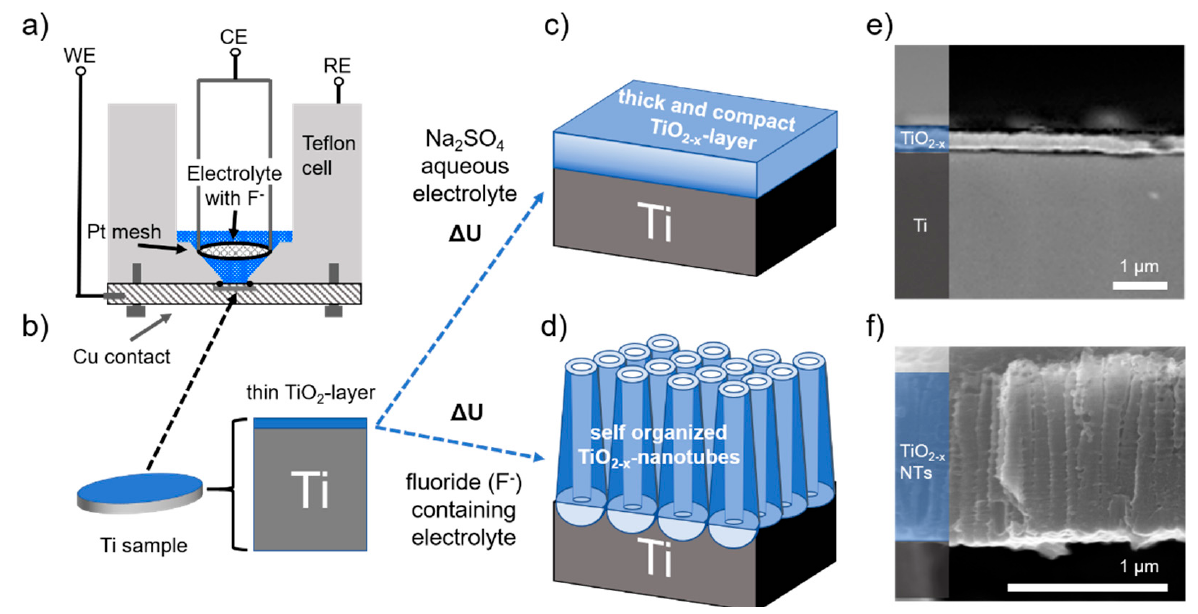
Figure 3. Scheme of the electrode formation and morphological characteristics. ( a ) Schematic of the electrochemical cell used for the anodization of a titanium metal disk shown in ( b ) as the working electrode. Anodization forms either a thick and compact solid TiO 2 − x layer ( c ) on the metal surface, or, in a fluoride-containing electrolyte ( d ), self-organized TiO 2 − x NTs. Cross-section SEM images of ( e ) the 200 nm thick oxide film and ( f ) approx. 1 µ m long TiO 2 − x NTs formed. The different layers are color-highlighted and labeled on the left side.